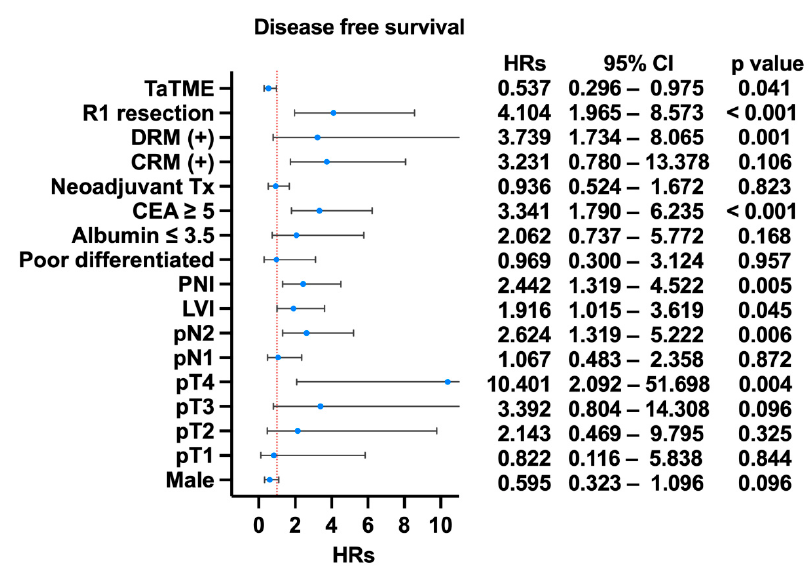
Figure 6. Summary of the risk factors for 3-year DFS.